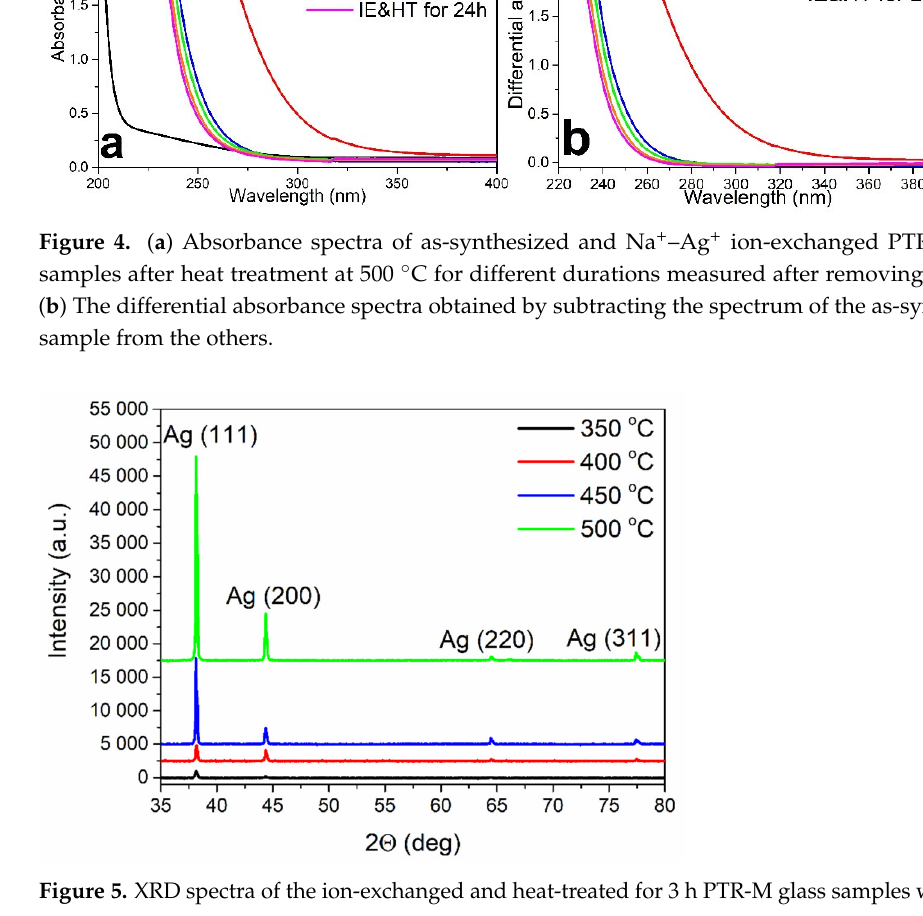
Figure 5. XRD spectra of the ion-exchanged and heat-treated for 3 h PTR-M glass samples with SNIF.